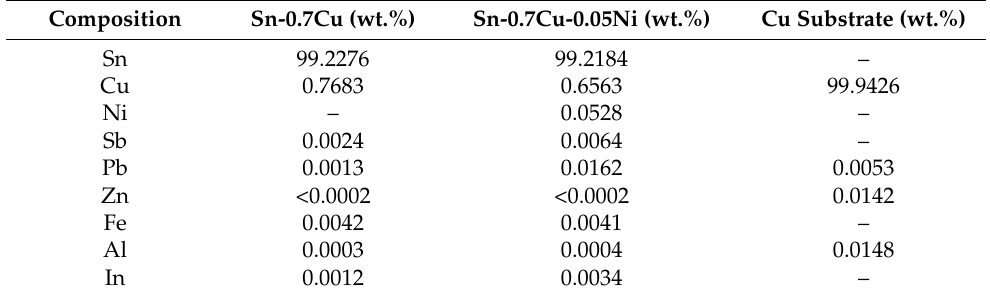
Table 1. The chemical composition analysis of lead (Pb)-free solder alloy and substrate (wt.%).